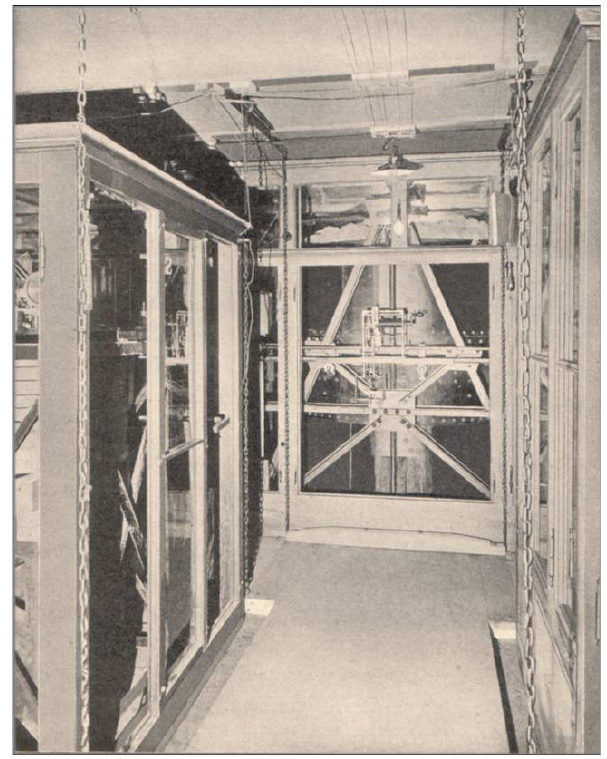
Figure 6. The seismograph room circa 1905. The suspension bridge to avoid stepping on the floor can be seen in the front. Undated picture taken from Wiechert